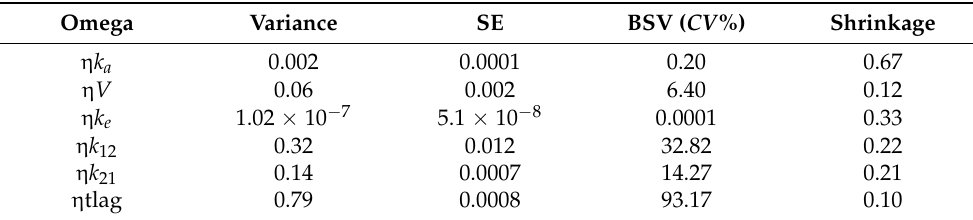
Table 2. Random effects of doxycycline after oral administration via drinking water at the dose rate of 20 mg/kg b.w./24 h for 5 days, alone or co-administered with N-acetylcysteine via feed at a dose rate of 100 mg/kg b.w./24 h for 5 days, in healthy and in M. gallisepticum -infected broiler chickens (n =